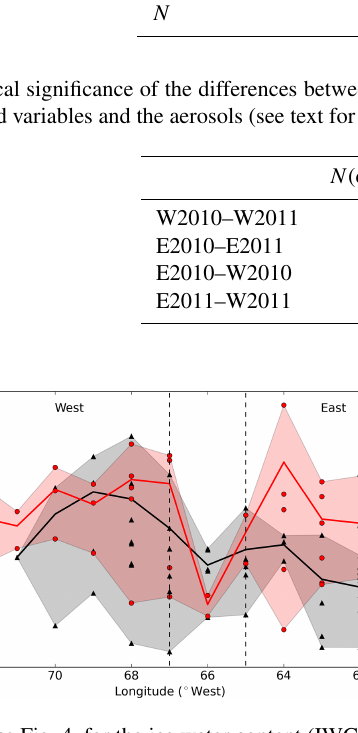
number of ice particles observed is roughly 5 to 6 orders of magnitude lower than the number of cloud droplets, and the relative amplitude of the variability higher (the standard de- viation of liquid droplet number concentration is about 50 % of the average values, while it is as high as or higher than averages for ice crystal number concentrations). Also,